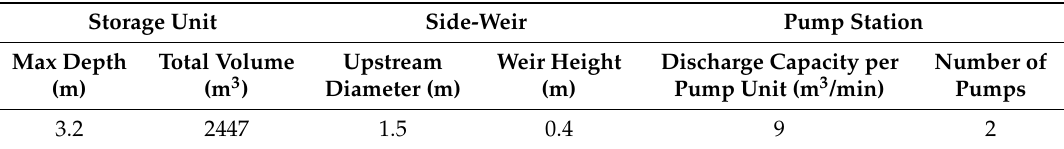
Table 1. Parameters of the detention reservoir facilities.